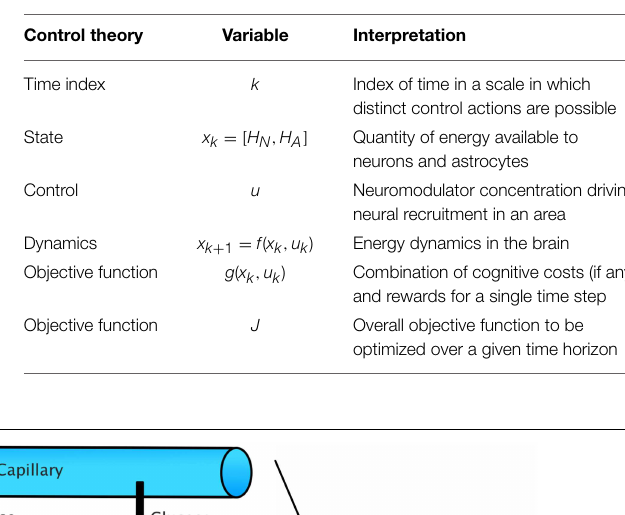
TABLE 1 | Proposed relationship between a control theoretic framework and the optimization of energy use in the brain over time.